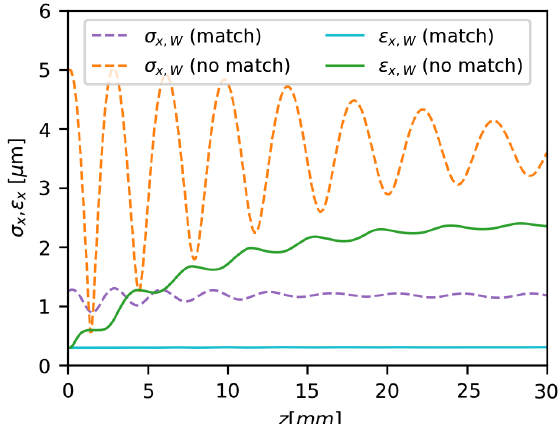
FIG. 4. Comparison between matched (purple) and mismatched (orange) envelope of the witness. The emittance growth of the matched case (cyan) is negligible, while in the mismatched case the emittance (green) grows from the injection value up to a saturation value of 2 . 4 μ